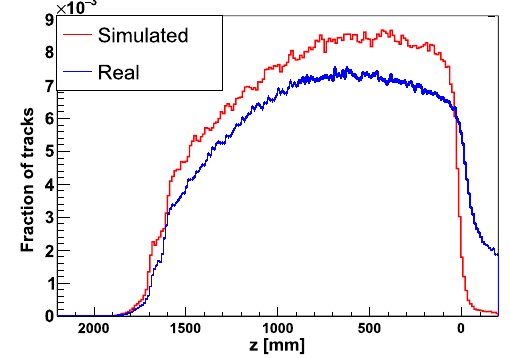
FIG. 12. The distribution of the point of closest approach of reconstructed tracks along the z axis (beam direction), for real data and MC simulation predictions.